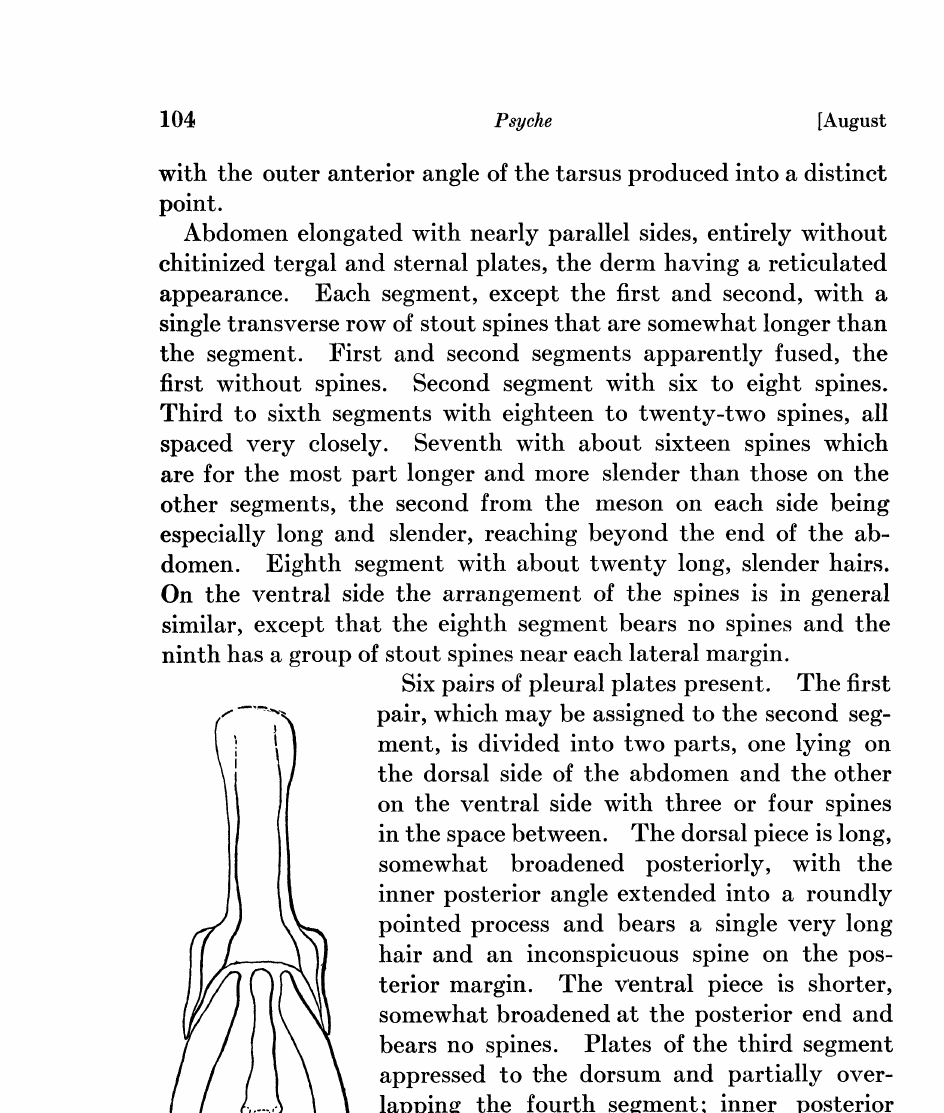
pair, which may be assigned to the second seg- ment, is divided into two parts, one lying on the dorsal side of the abdomen and the other on the ventral side with three or four spines in the space between. The dorsal piece is long, somewhat broadened posteriorly, with the inner posterior angle extended into a roundly pointed process and bears a single very long hair and an inconspicuous spine on the pos- terior margin. The ventral piece is shorter, somewhat broadened at the posterior end and bears no spines. Plates of the third segment appressed to l:he dorsum and partially over- lapping the fourth segment; inner posterior angle produced into a rounded tooth and a single long hair on the posterior margin. Plates of the fourth segment similar but smaller, pro- jecting from the body wall and likewise bear- ing a long stout hair. Plates of the fifth to Fig. 5. Fahrert- seventh segments similar to those of the fourth holzia tribulosa sp. nov.; genitalia of but somewhat smaller and without male